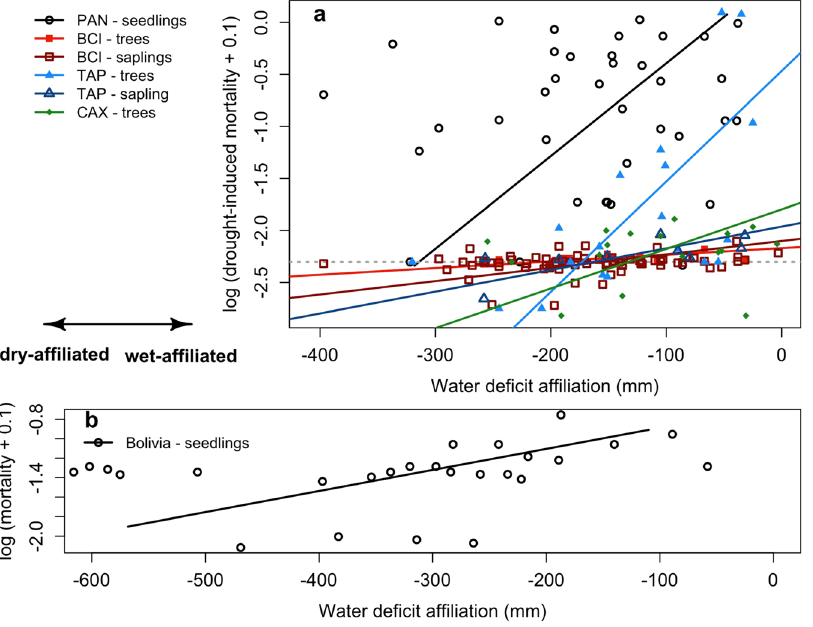
Figure 2. Standardized major axis regression (SMA) between log-transformed drought-induced mortality ( ∆ m) and water deficit affiliation (WDA) in different case studies and for different life history stages. ( a ) Two through-fall exclusion experiments in the Brazilian Amazon, Tapajós 40 and Caxiuanã 16 , field observations from the 1982–83 El Niño drought 17 and a seedling drought experiment in Panama 4 ; grey horizontal line indicates zero ∆ m, so that genera above this line experienced greater drought mortality than baseline mortality. ( b ) Seedling drought experiment in Bolivia 12 , where y-axis represents log transformed mortality rates (m) + 0.1 during the drought experiment. Trees include stems over 100 mm diameter. The size range of saplings sampled was 10–99 mm D in BCI and 20–99 mm in Tapajós. WDA data were extracted from ref.